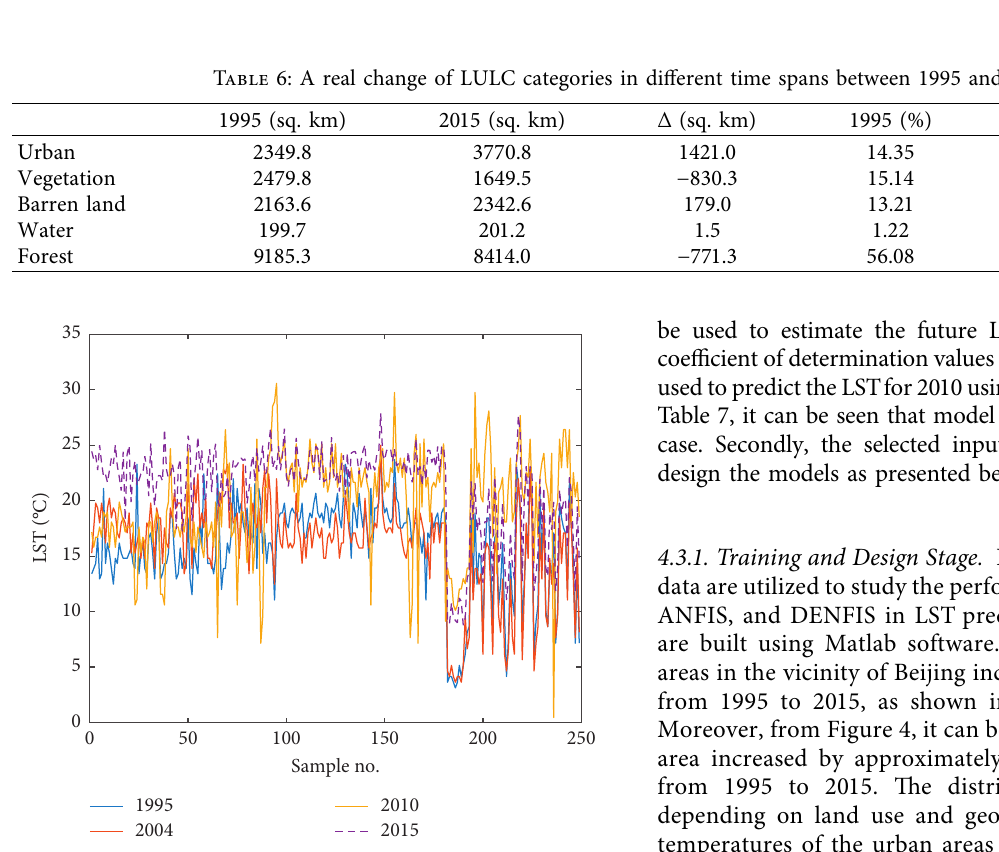
Figure 5: LST for the month of April at the specified four